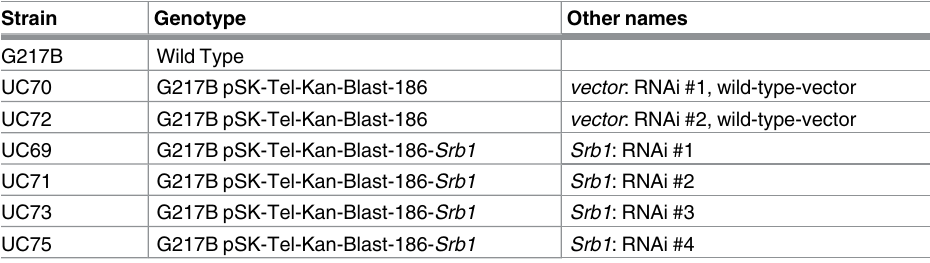
Table 1. H . capsulatum